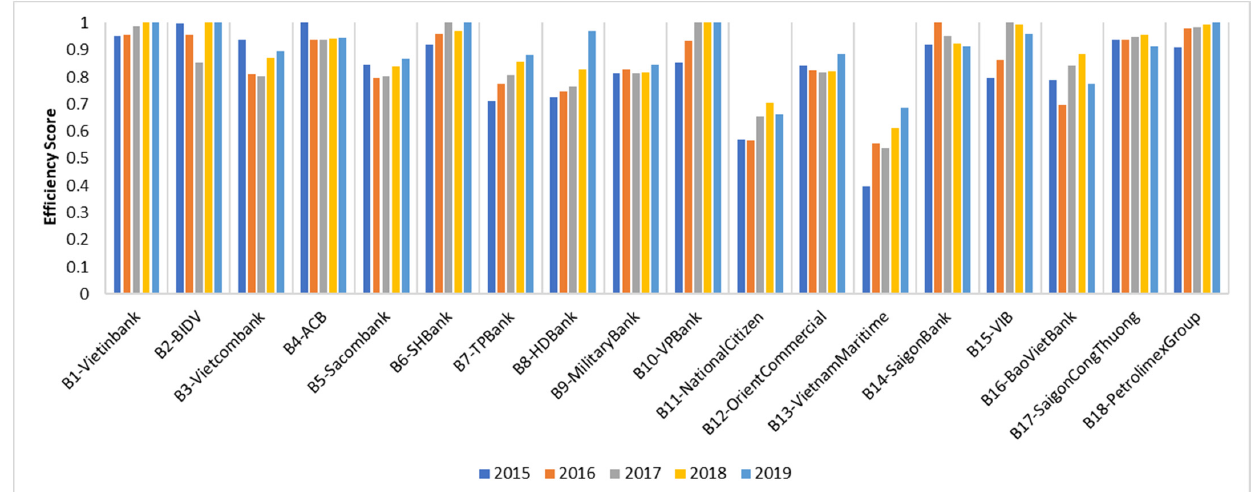
Figure 5. Variation over a year of the DMUs (Window of 5 years).